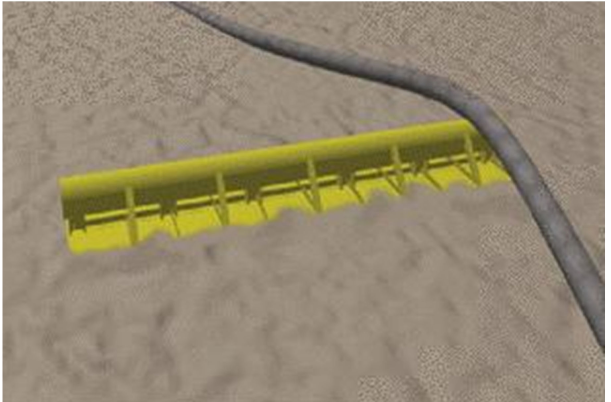
Figure 1. The installation of sleepers (yellow) to control buckling in the pipe structure (black). Reprinted with permission from Ref. [26]. 2018,